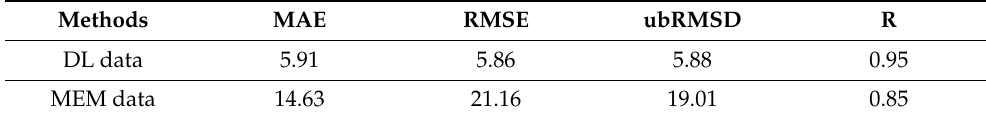
Table 2. Different evaluation metrics in test dataset of DL and MEM